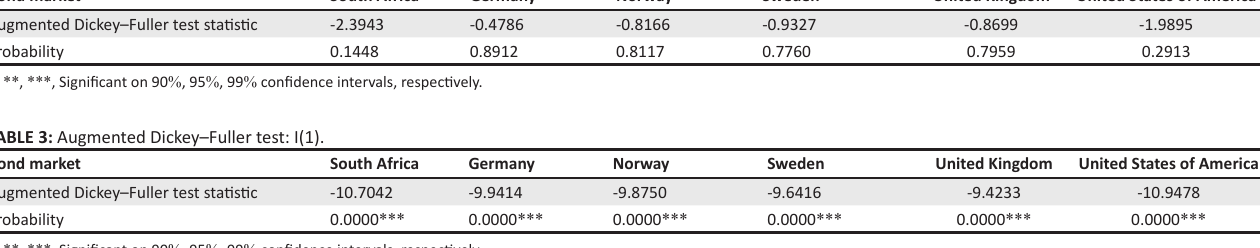
TABLE 2: Augmented Dickey–Fuller test: Level. Bond market